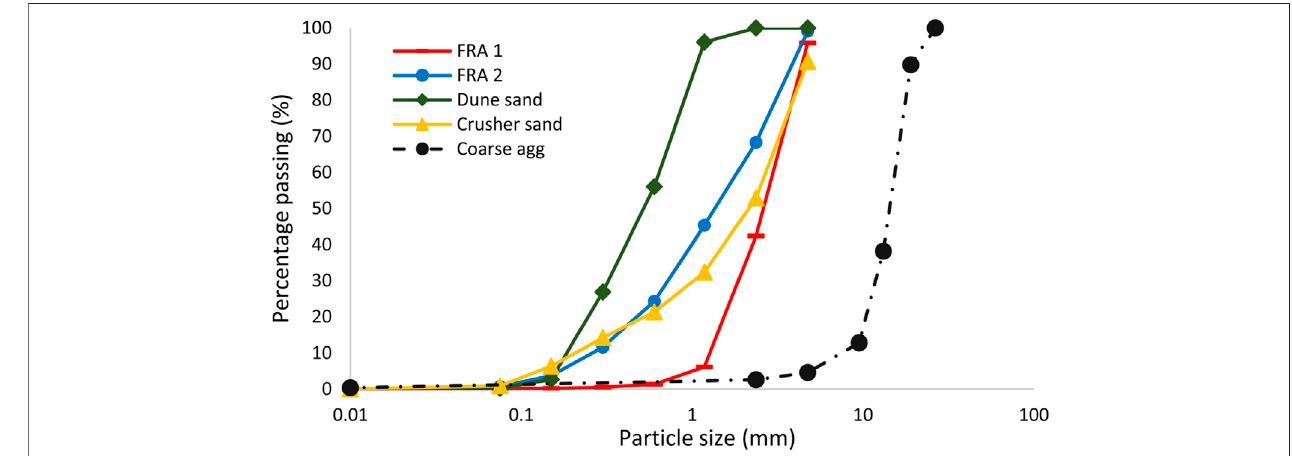
FIGURE 3 | Particle size distribution of aggregates.